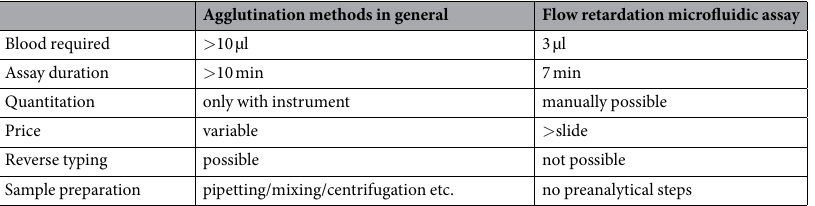
Table 2. Comparison of widely used agglutination methods (slide, tube microplate or column/gel filtration format) 8 and the presented flow retardation microfluidic